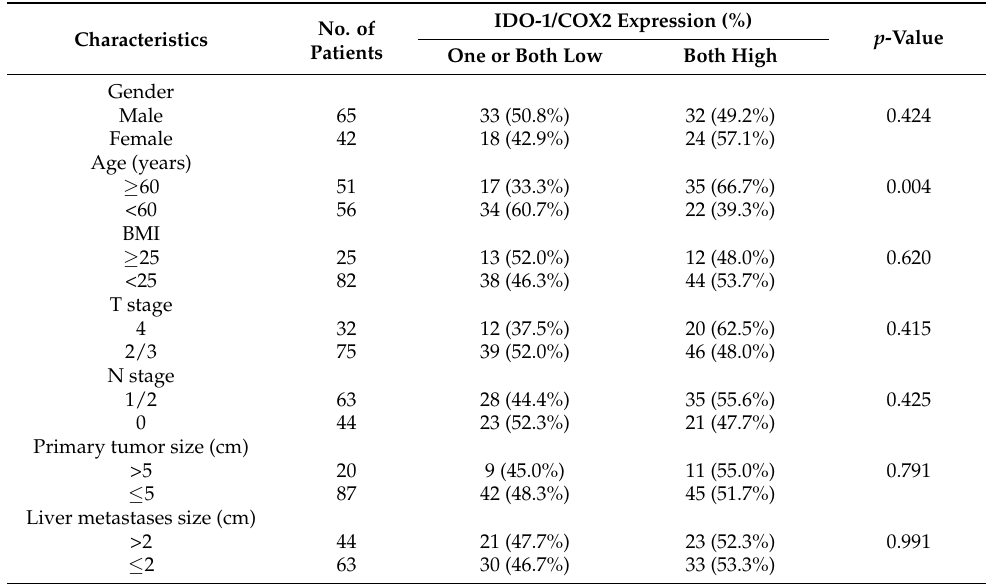
Table 1. Correlation of IDO-1/COX2 expression with clinicopathological parameters in patients with liver metastases of colorectal cancer.